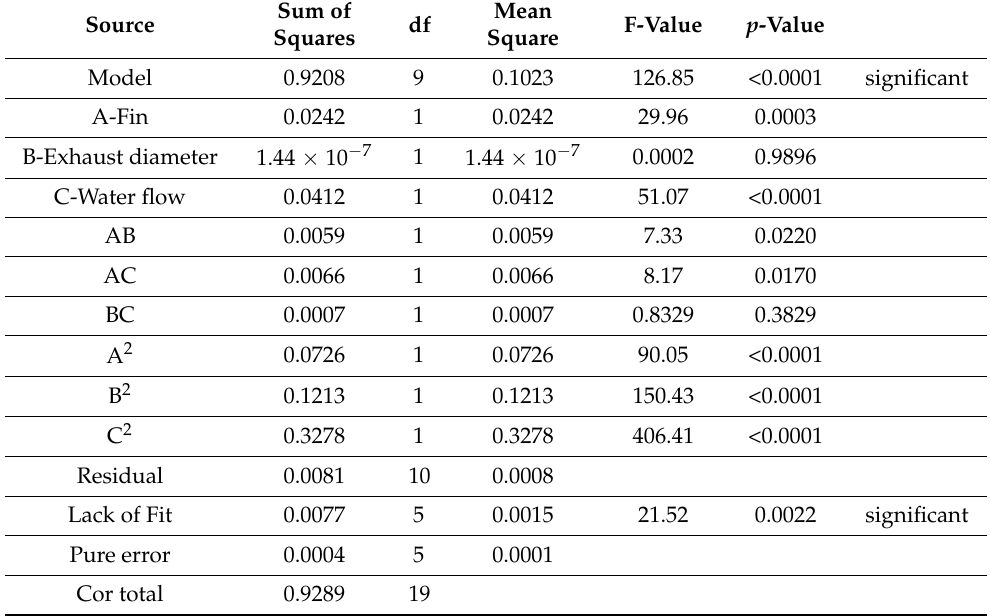
Table 4. Analysis of variance (ANOVA) for the efficiency